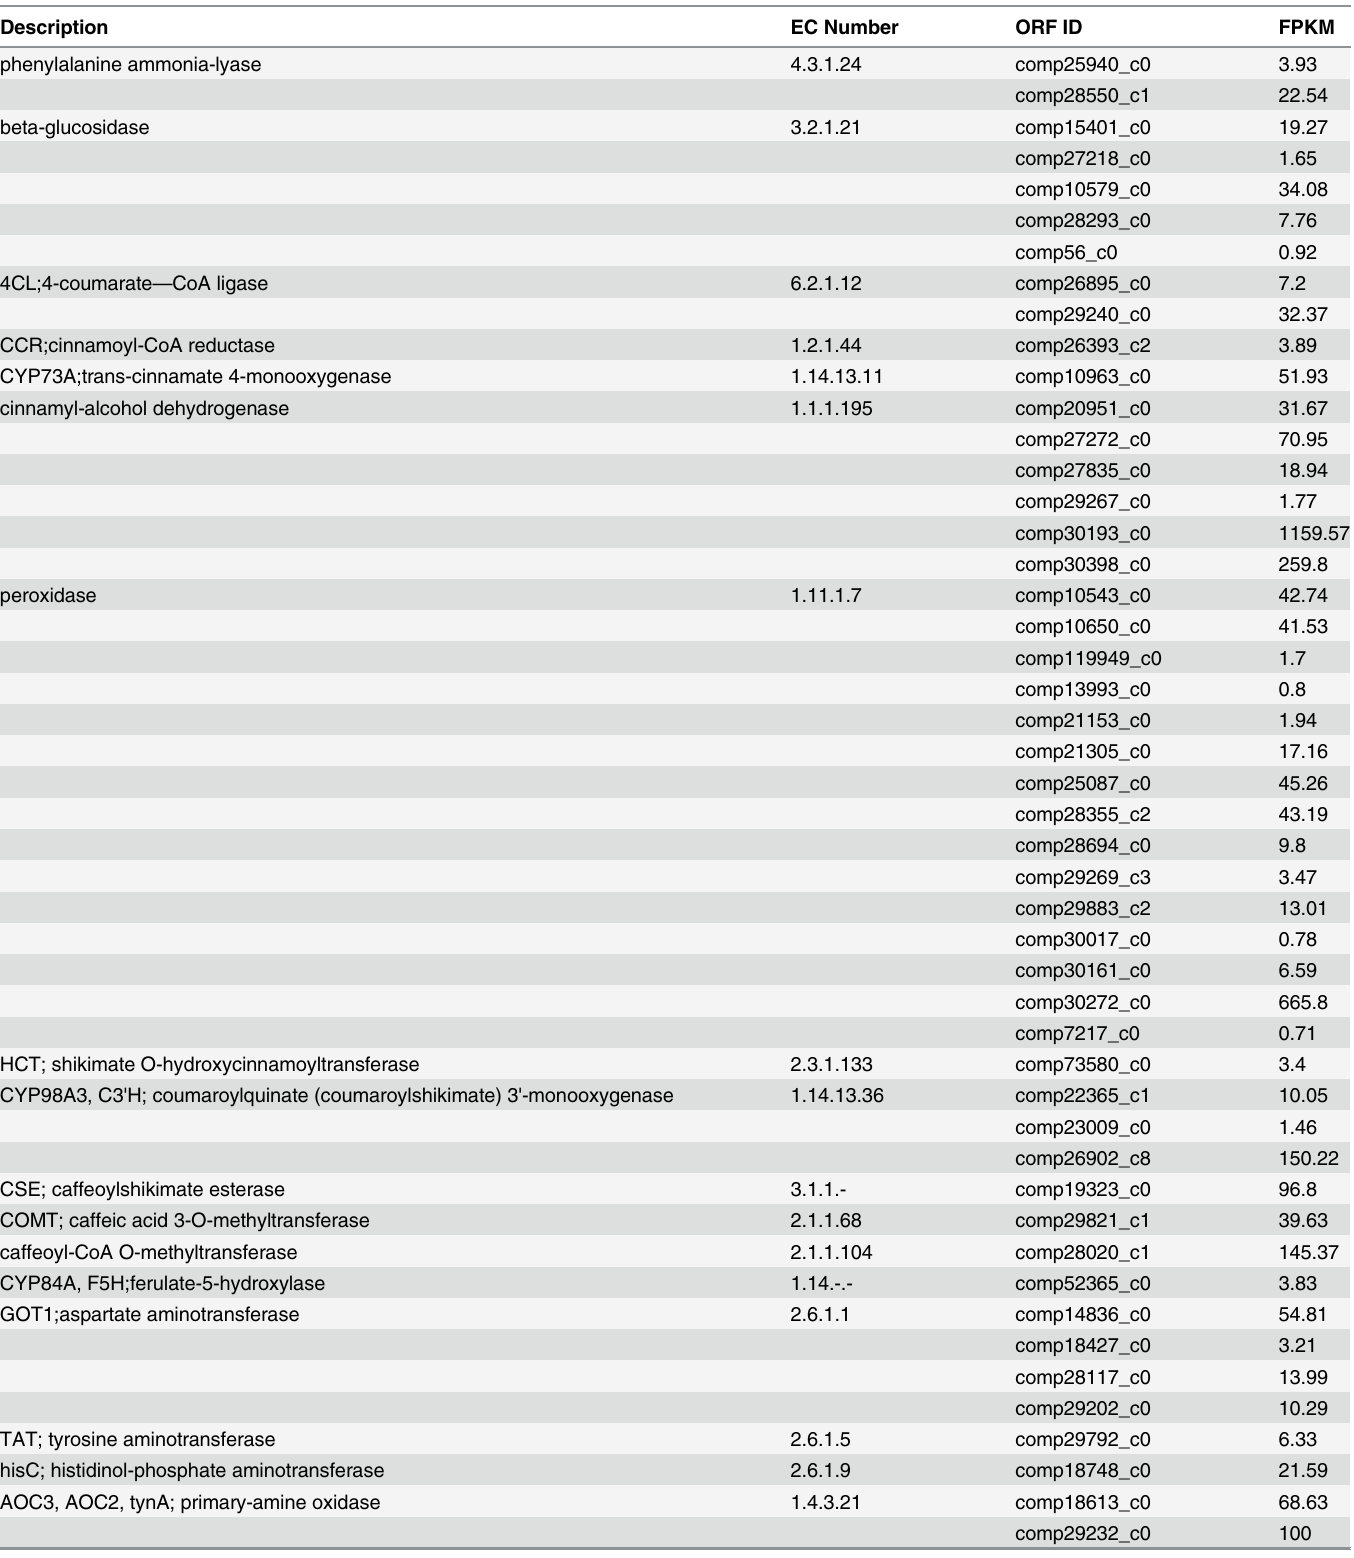
Table 6. Expression profile of related genes in biosynthesis of lignin and